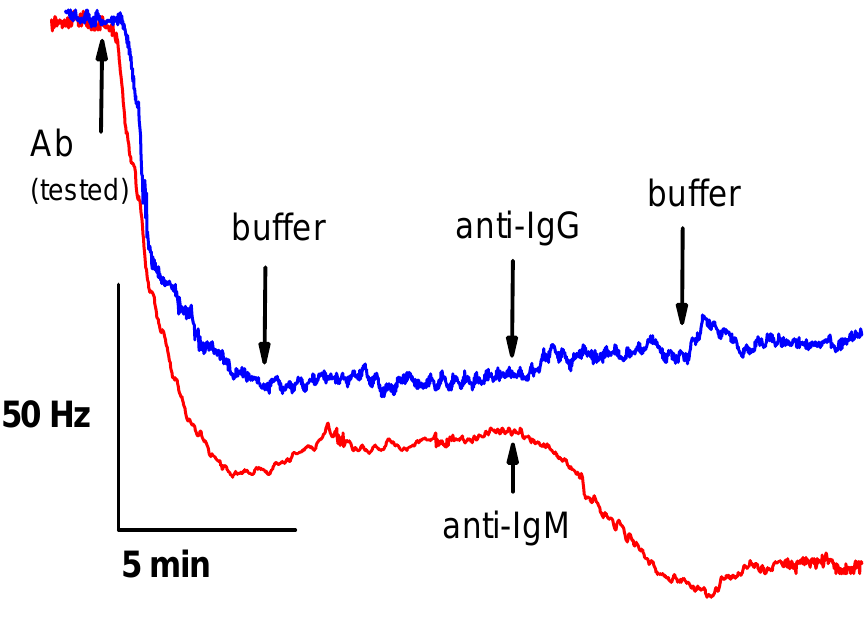
Fig. 4. Isotyping of the mAb 4H3B9D3 using the piezoelectric sensor modified with LPS from